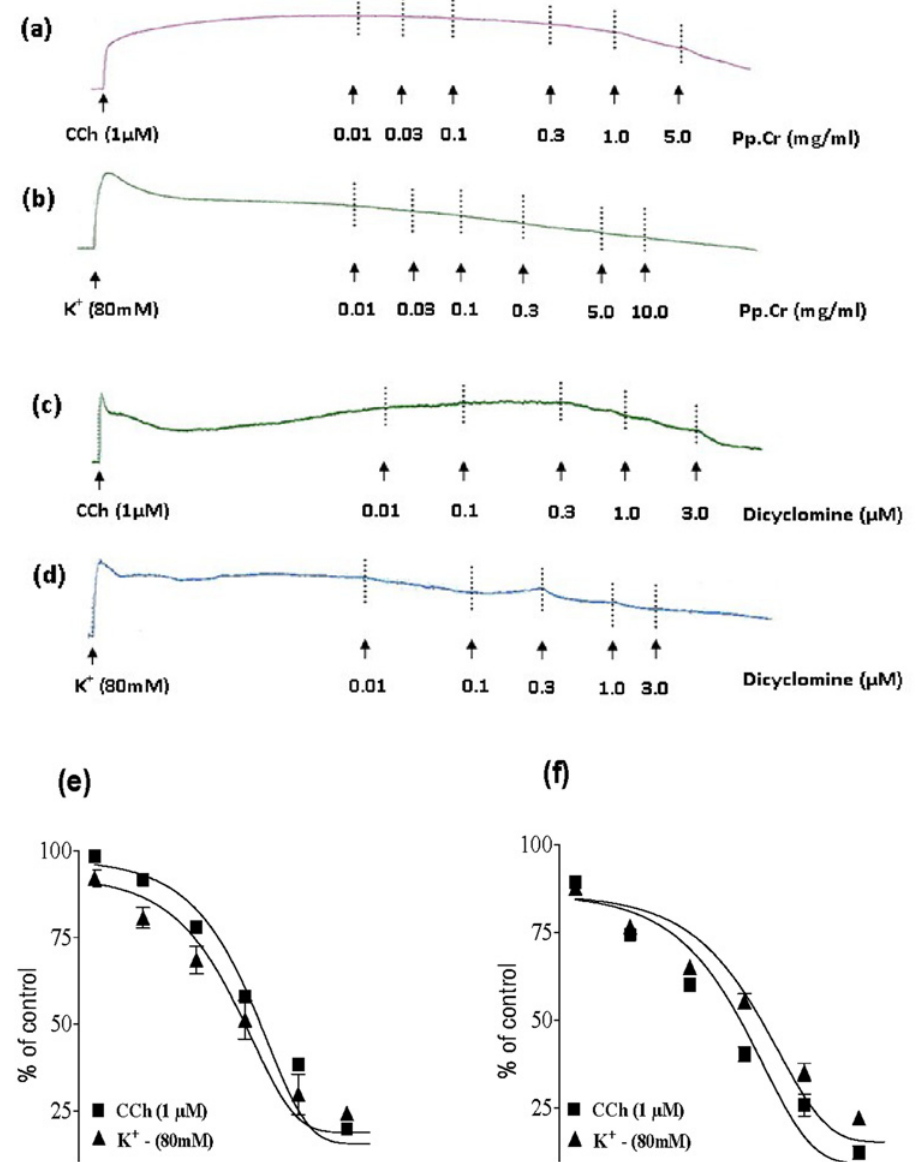
Fig 4. Concentration dependent broncho-relaxant effect of a ethanolic extract of Pyrus pashia (Pp.Cr) (a, b and e) and dicyclomine (c,d and f) on carbachol (CCh: 1 μ M)- and high K + (80 mM)- induced contractions in isolated rabbit tracheal preparations. Values are the mean ± SEM, n =